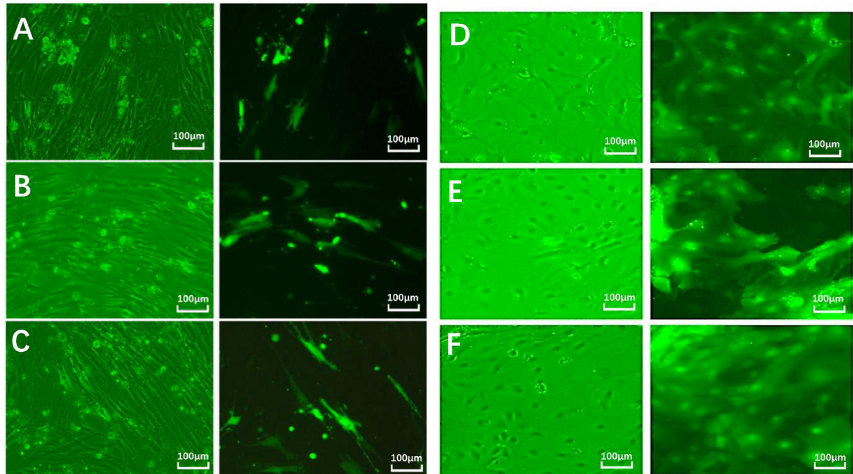
Figure 6. Cell transfection. Note: green fluorescent expression after transfection of fibroblasts (left) and epithelial cells (right) for 24h (100µm). Note: A–D show a cell microscope diagram after transfection of sh-EDA for 24h under bright-field (left) and fluorescence condi- tions (right). B–E show a cell microscope diagram after transfection of sh-EDAR for 24h under bright-field (left) and fluorescence conditions (right). C–F show the negative control vector (NC-sh-RNA).